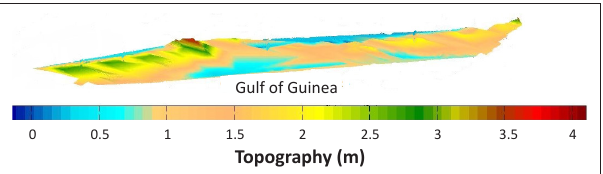
FIGURE 5: Model of the beach